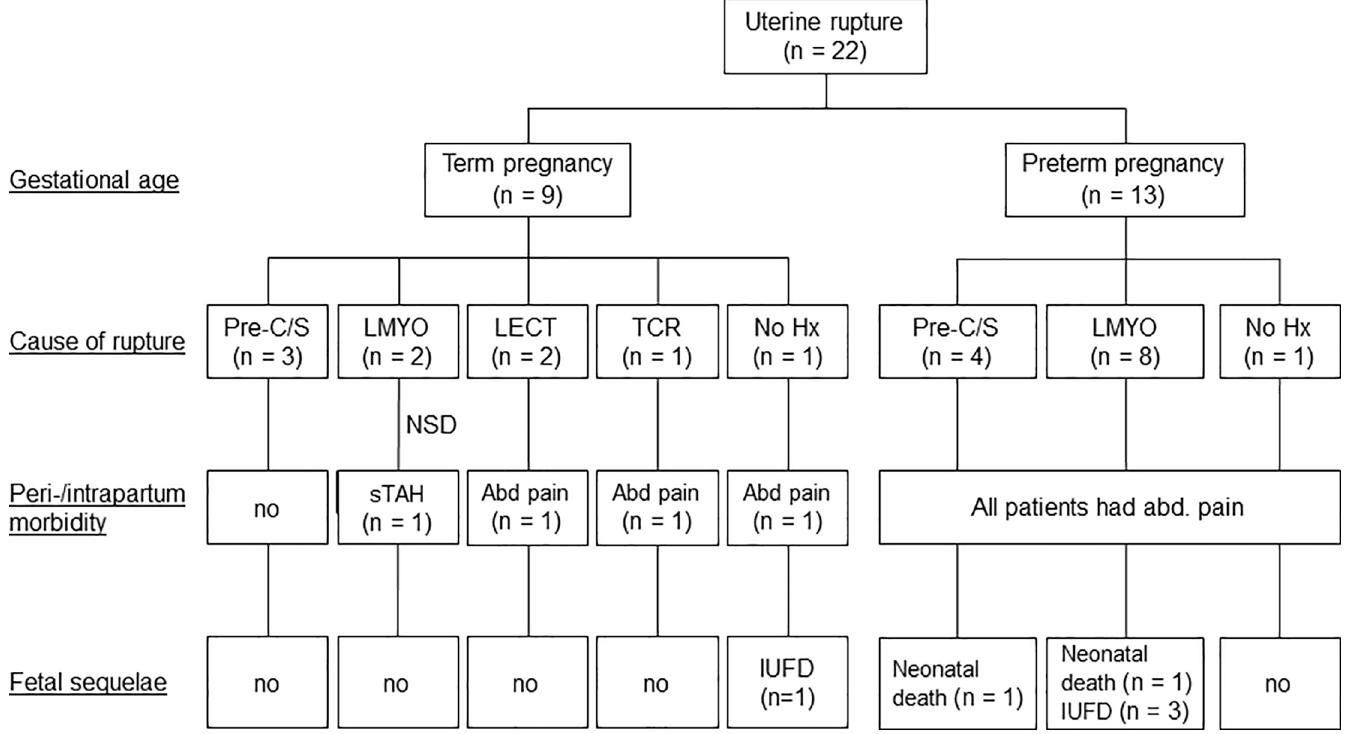
Fig 1. Maternal morbidity and fetal sequelae of women with uterine rupture at different gestational ages. Abbreviations: abd, abdominal; Hx, history; IUFD, intrauterine fetal death; LMYO, laparoscopic myomectomy; LECT, laparoscopic wedge resection of cornual pregnancy, NA, not applicable; Pre-C/S, previous cesarean section; TCR-MYO, trans-cervical resection of myomectomy; sTAH, subtotal hysterectomy.